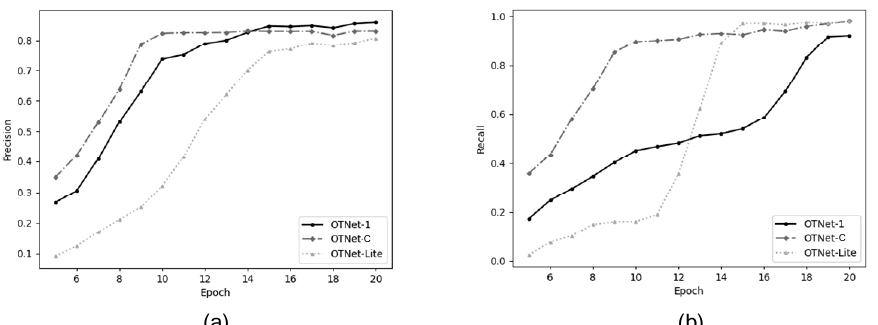
Figure 4. The changing of the precision and recall rate through the training process. ( a ) The precision rate changing. ( b ) The recall rate